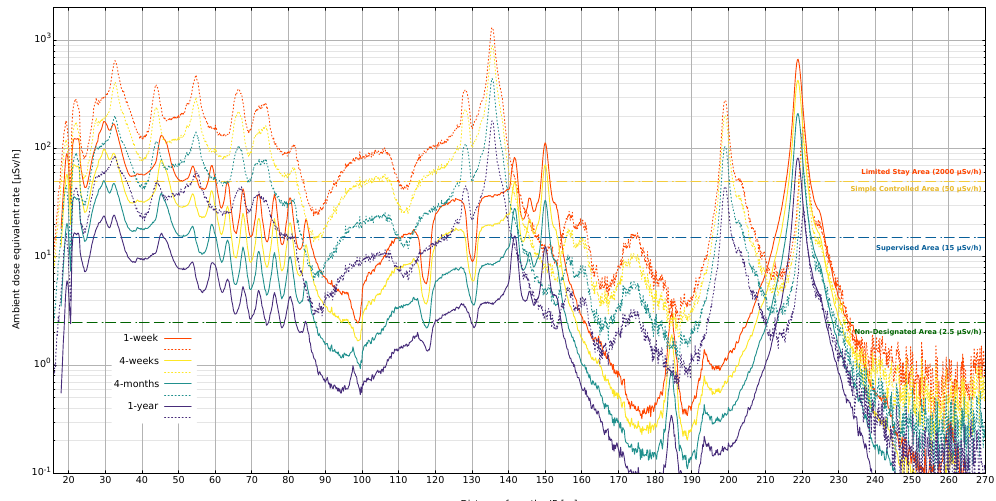
Figure 9. LHC LSS1 Vs HL-LHC LSS5 v1.5 (vertical crossing). Residual dose rate at different cooling times after Run 3 (LHC, solid line) and Run 4 (HL-LHC, dash line) at 100 cm distance from machine axis. CERN limits for radiation area classification (temporary-stay, i.e., <20% working time) are